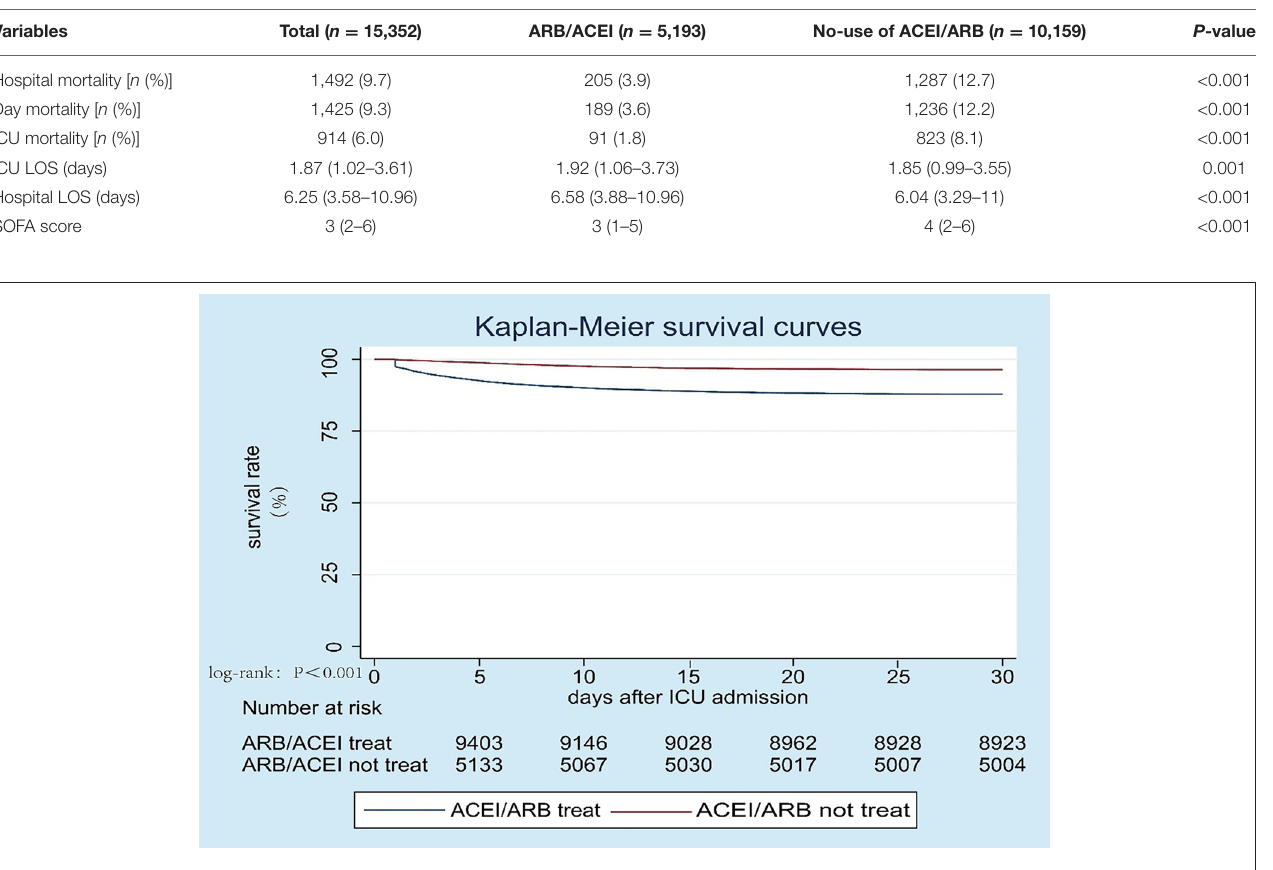
FIGURE 2 | Kaplan-Meier survival curve between patients treated with ACEI/ARB and those without ACEI/ARB, log-rank test: P < 0.001.